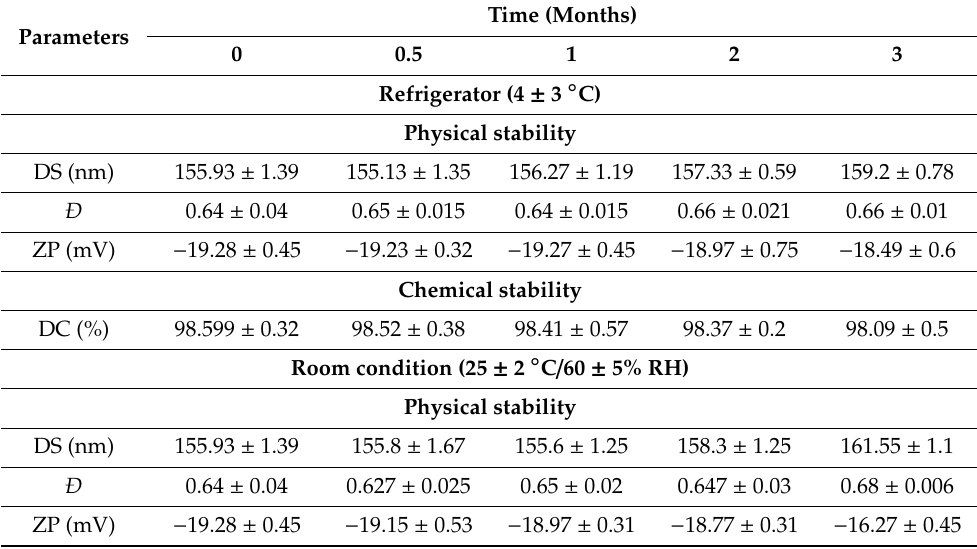
Table 9. Stability studies for AZM-S-F1 (H) formulation under the three di ff erent storage conditions. Mean ± SD, n =